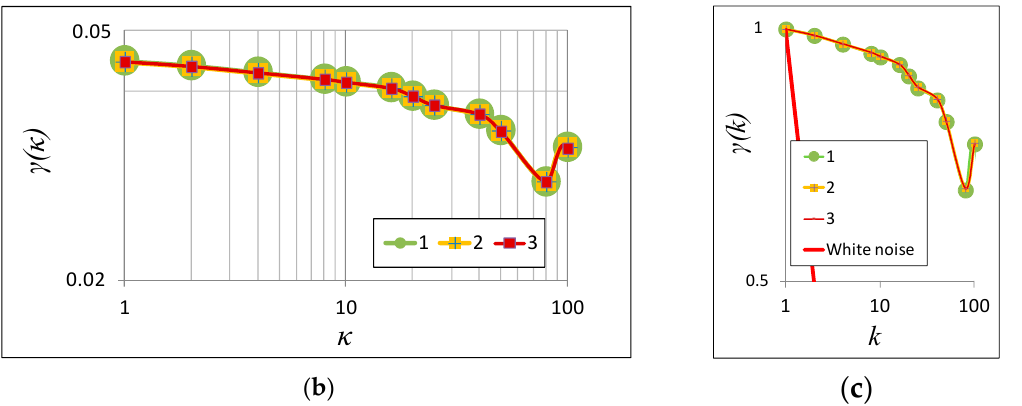
Figure 8 . ( a1 – a3 ) Transformation of landscape of Plastiras caused by the fluctuation of the lake water elevation in the area of normal dead zone; ( b ) climacograms and ( c ) standardized climacograms of images ( a1 – a3 ) .